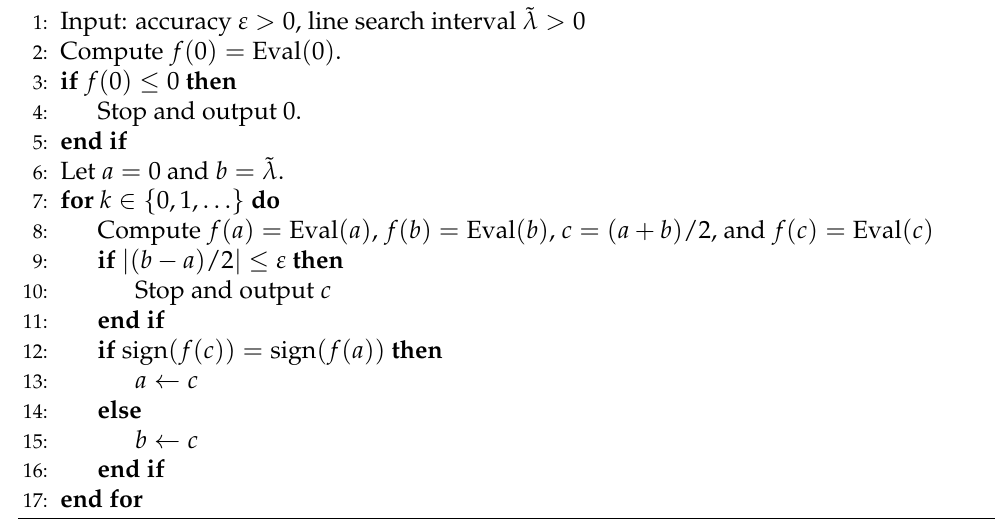
Algorithm 1 Primal-Dual Method with Bisection Line Search.